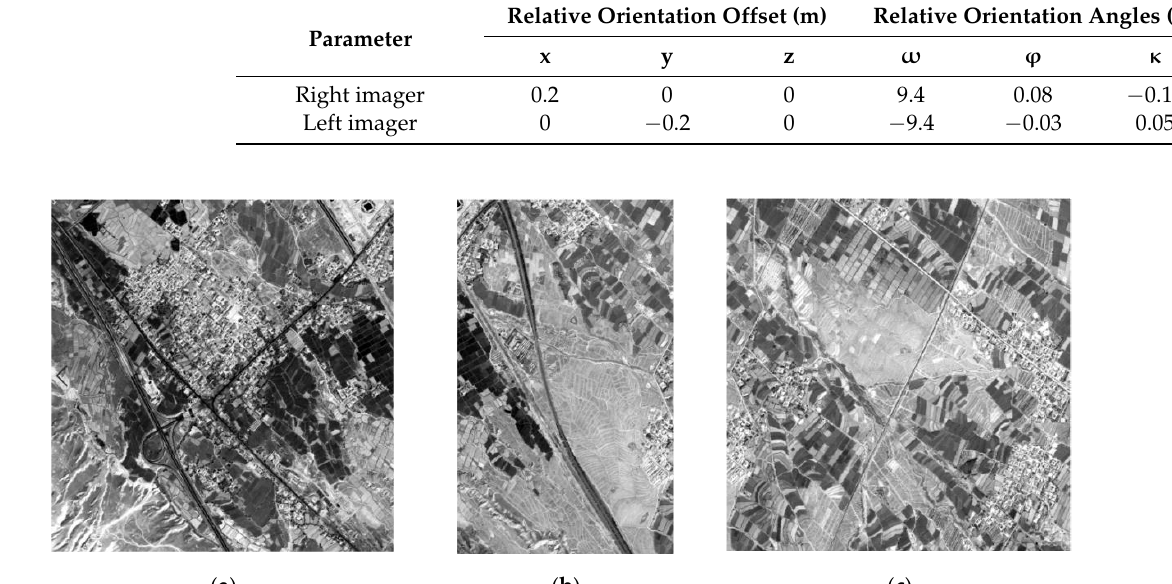
Table 2. Simulated relative orientation parameters.